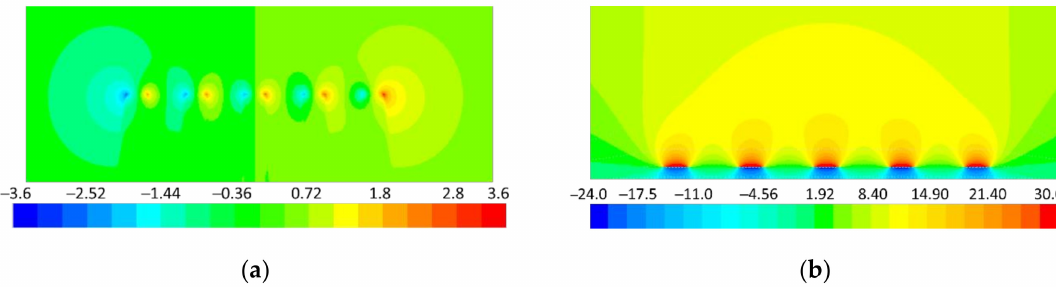
Figure 16. The contour plot of the flow of a wind turbine row: ( a ) tangential velocity around turbines; ( b ) pressure in the induction